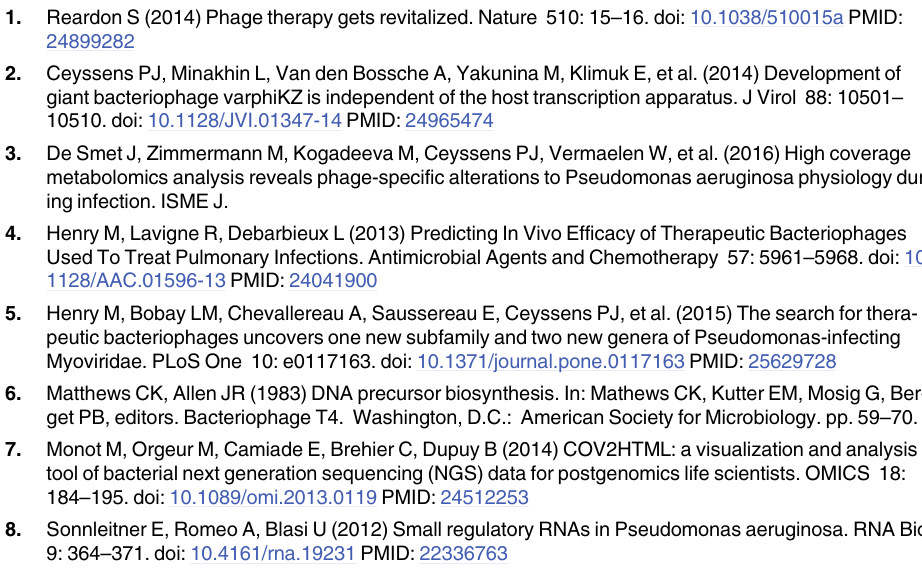
S3 Fig. Bacteriophage PAK_P3 expresses many antisense transcripts. Mapped reads were formatted into graph files for visualization in a strand-specific manner (black and pink repre- sent reads mapping the forward and the reverse strands, respectively) using COV2HTML. The annotated cis -antisense RNAs genes are indicated as grey arrows and open-reading frames annotated in PAK_P3 are shown as blue arrows. Data obtained 3.5 min and 13 min following PAK_P3 infection are presented in upper and lower part,